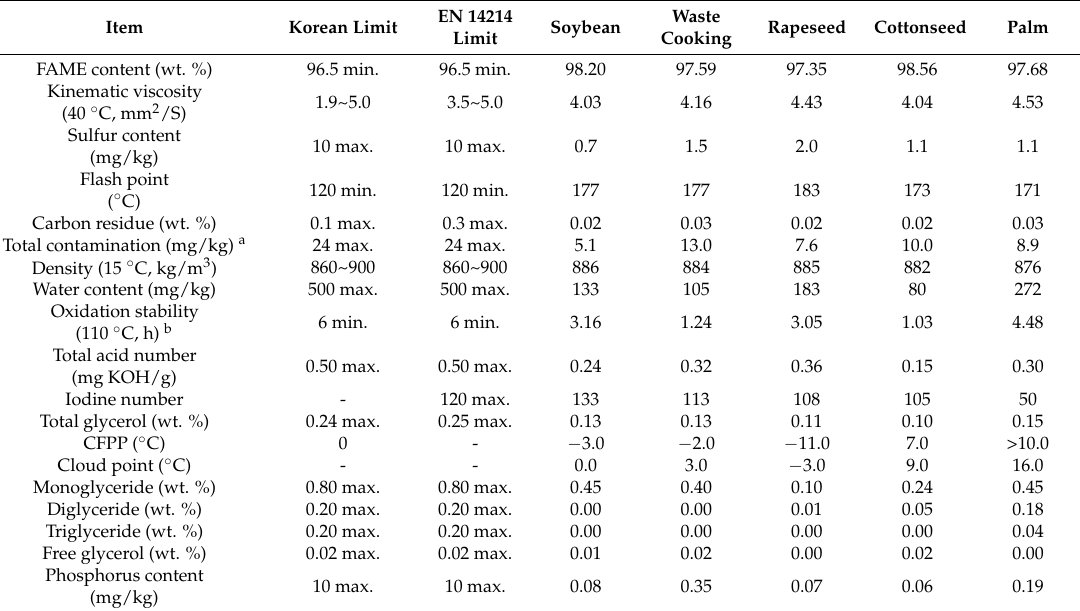
Table 1. Physicochemical characteristics of BD samples.